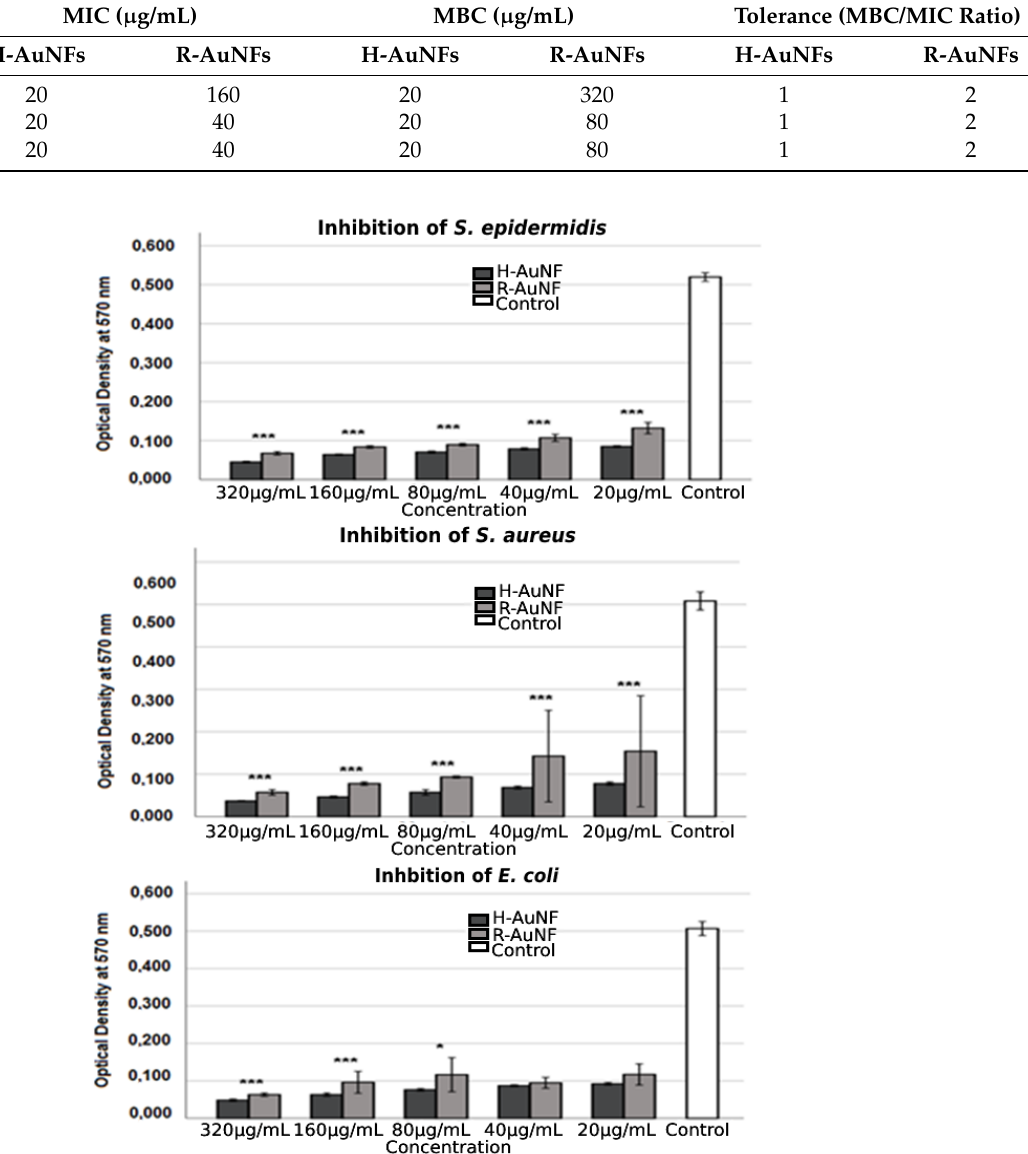
Table 1. The MIC and MBC values of AuNFs against tested bacterial